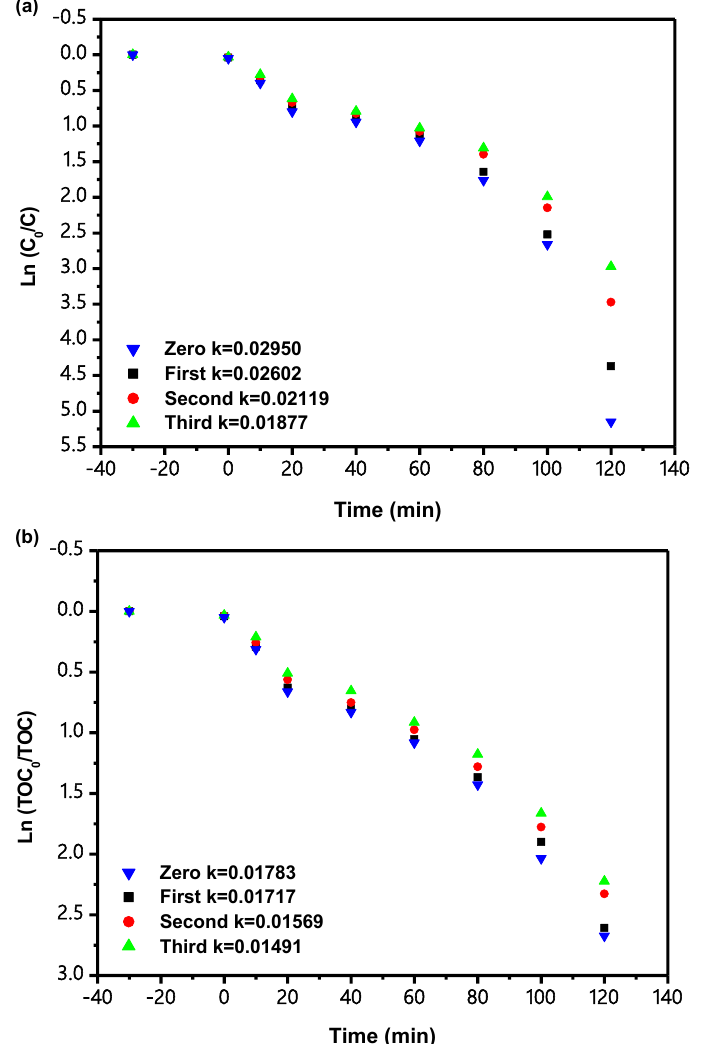
Figure 21. ( a ) Observed FOK plots for the PCD of IC with IBH as photocatalyst under VLGI for three cycle degradation tests. ( b ) Observed FOK plots for TOC during PCD of IC with IBH as photocatalyst under VLGI for three cycle degradation tests.